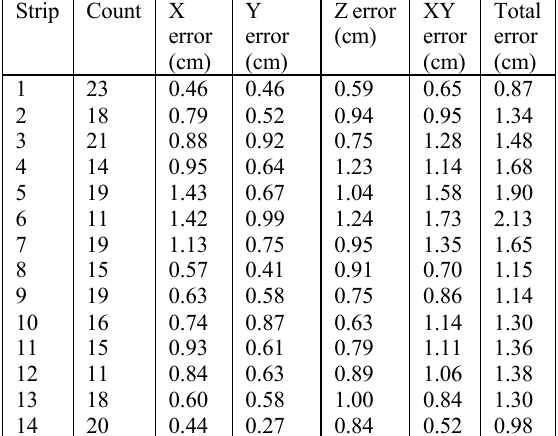
Table 4. RMSE GCP points